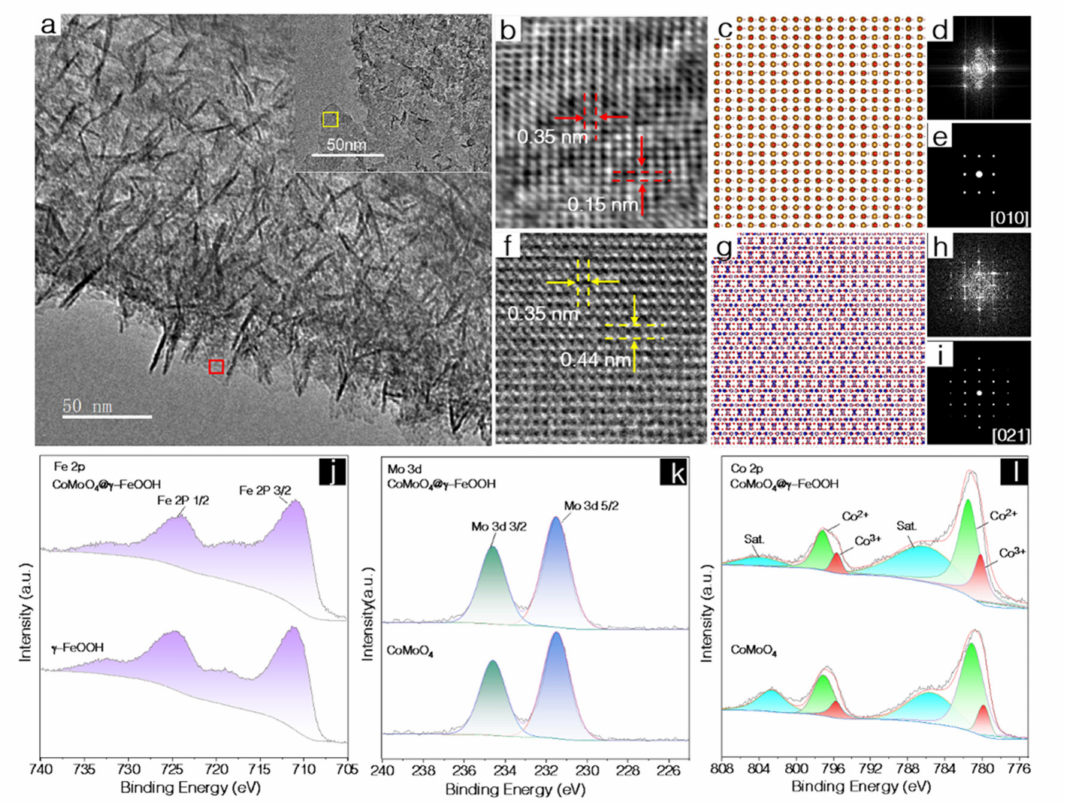
Figure 3. ( a ) Low magnification TEM image of CoMoO 4 @ γ -FeOOH’s heterostructure, insets show the γ -FeOOH region (red rectangle), and CoMoO 4 region (yellow rectangle). ( b ) Magnified HRTEM view of the crystalline region of γ -FeOOH. ( c ) The crystal structure model of γ -FeOOH observed along the [010] axis. ( d ) FFT of the ( b , e ) simulated FFT of the crystal structure model of γ -FeOOH observed along the [010] axis. ( f ) Magnified HRTEM view of the crystalline region of CoMoO4. ( g ) The crystal structure model of CoMoO4 observed along the [021] axis. ( h ) FFT of the ( f , i ) simulated FFT of the crystal structure. ( j ) High-resolution Fe 2p XPS spectra of CoMoO 4 @ γ -FeOOH and CoMoO 4 . ( k ) High-resolution Mo 3d XPS spectra of CoMoO 4 @ γ -FeOOH and CoMoO 4 . ( l ) High-resolution Co 2p XPS spectra of CoMoO 4 @ γ -FeOOH and γ